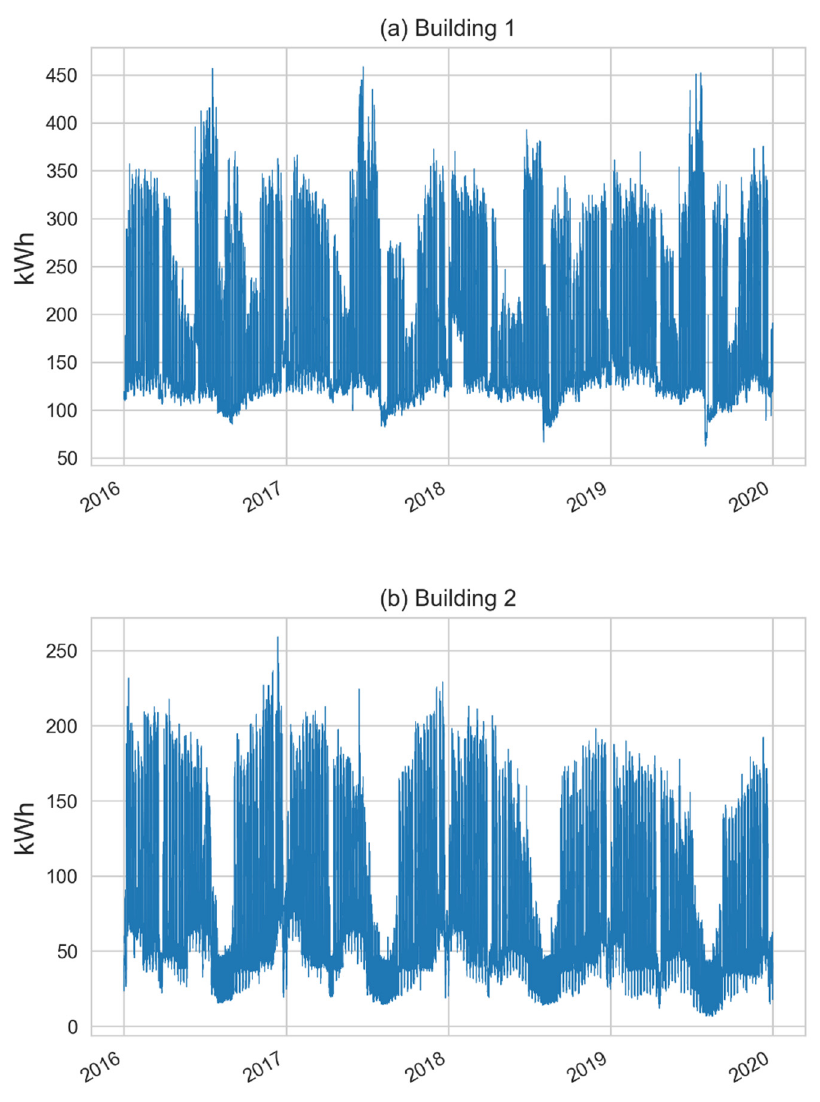
Figure 1. ( a ) Energy consumption and general trends of building 1; ( b ) energy consumption and general trends of building 2.